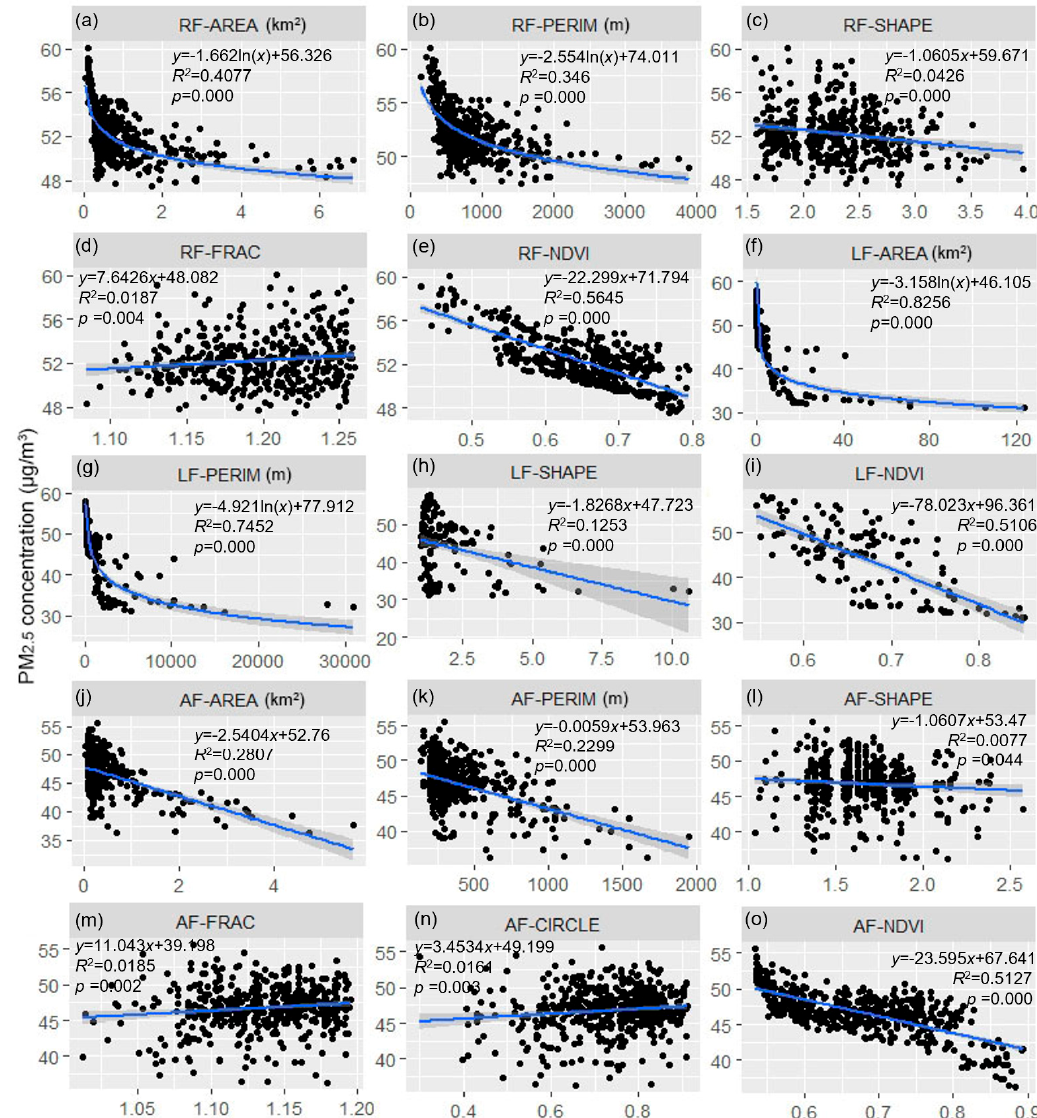
Figure 3. Regression analysis of PM 2.5 concentration and forest patch characteristics parameters.